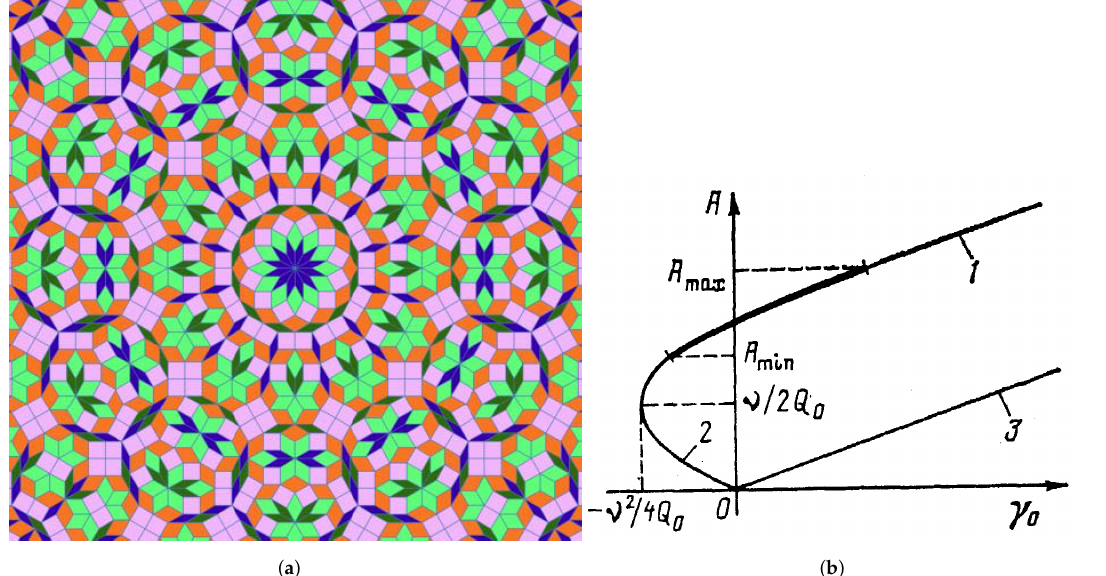
Figure 8. ( a ) The shape of the dodecagonal quasiperiodic pattern, reprinted with permissions from Ref. [103]. ( b ) The pattern’s amplitude, given by Equation (119) vs. the strength of the linear gain ( γ 0 > 0) or loss ( γ 0 < 0), reprinted with permissions from Ref. [9]. Stable and unstable solutions are represented, respectively, by bold and thin lines. Branches 1, 2 and 3 pertain, respectively, to the solutions with cos Φ l = + 1 and − 1 in Equation (118). Parameters Q 0 , A min , and A max are defined as per Equations (120), (122) and (124),